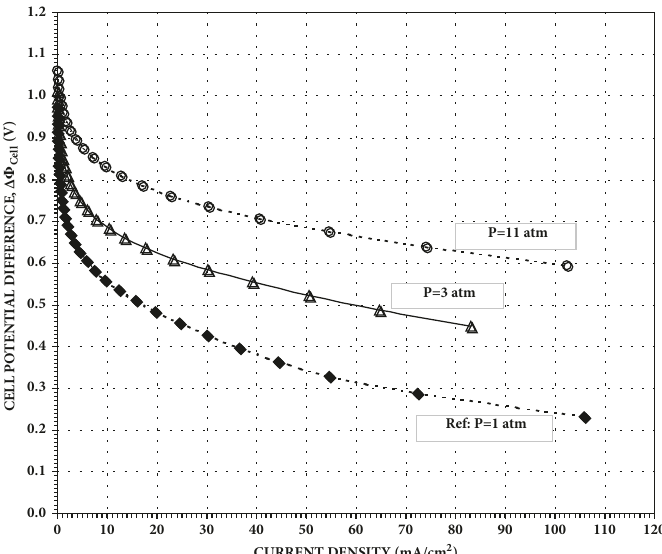
Figure 13: The effect of the fuel cell operating pressure, P (atm), on the polarization curve for a direct propane fuel cell (DPFC) model at 150 ∘ C. The values of P (atm) for the above three cases (y atm, (ii) open triangles: 3 atm, and (iii) solid diamonds: 1 atm (reference case). All the other parameters were the same as the reference case mentioned in Table